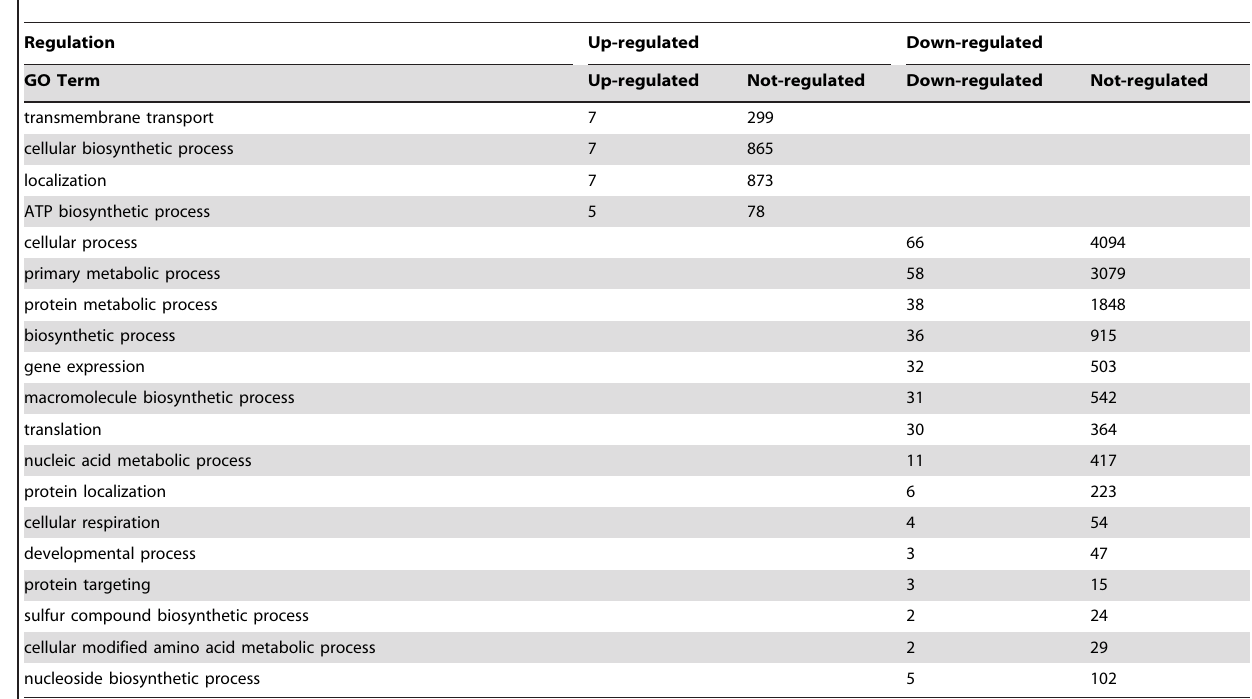
Table 4. Biological functions significantly ( p , 0.05) enriched in the sets of up-regulated and down-regulated core genes